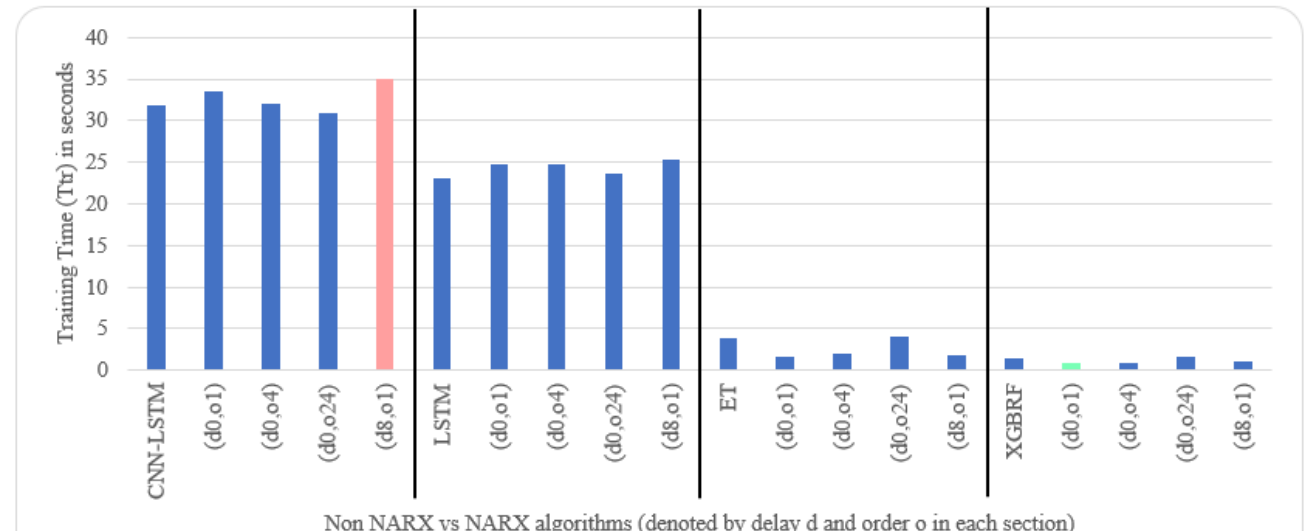
Figure 26. Evaluation results of non-NARX and NARX in terms of offline training time for the Beijing dataset.